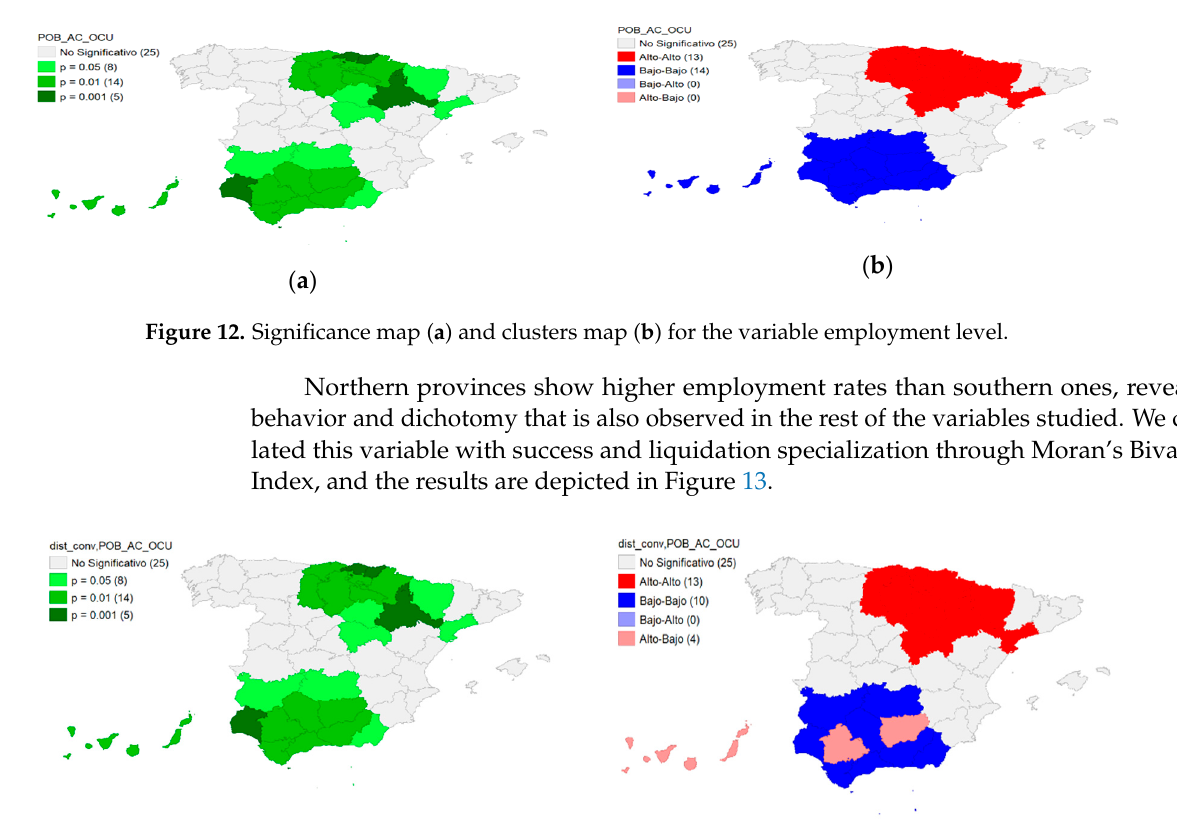
( d ) Figure 11. Significance and clusters maps for the variable business size large-medium ( a , b ) and significance and clusters maps for the variable business size small ( c , d ). When applying Moran’s Bivariate Index to the variable medium and large companies with respect to the success specialization, it results in a value of 0.237 (z = 3.4742). This result, which again reveals spatial dependence and the existence of a cluster with a higher proportion of medium and large companies than the rest of the country, and also in which these firms tend to have higher success rates. When this index is applied to liquidation, the value of z is under 1.96, so no spatial dependence is shown. When calculating the index for small companies, a cluster is detected in the north, which presents a low proportion of small companies and high success rates. There are companies with high success rates in the west of the country and a high proportion of small companies, with an index of − 0.234 (z = − 3.4336). Therefore, size is also a significant variable to predict the bankruptcy outcome dis- cerning by location. In this case, larger companies tend to have higher success rates than smaller ones. The resource-based theory supports this conclusion in [32]. 4.5. Contrasting Unemployment Levels with the Bankruptcy Outcome by Province The provinces’ employment levels were also suggested as a possible determinant for